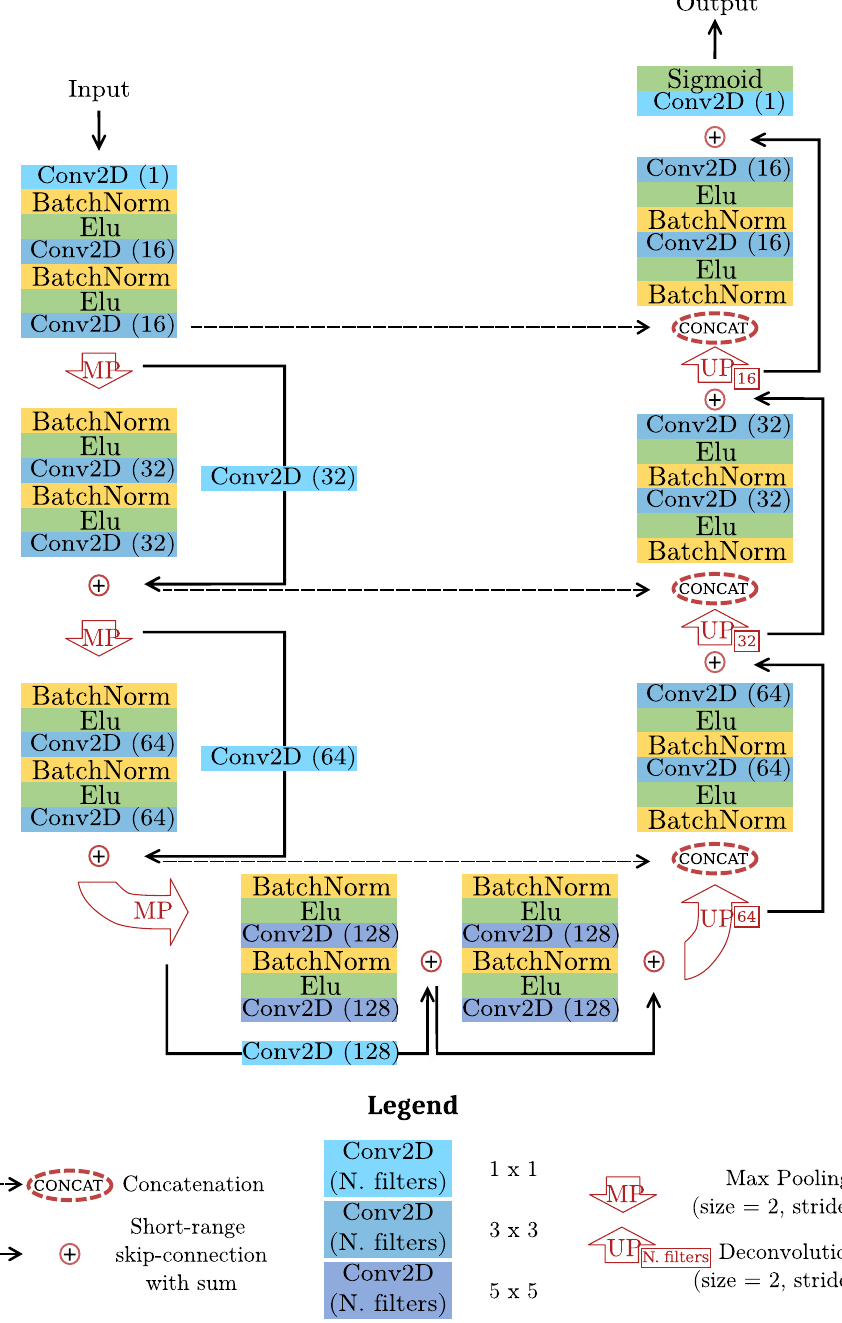
Figure 2. Model scheme. Each box reports an element of the entire architecture (individual description in the